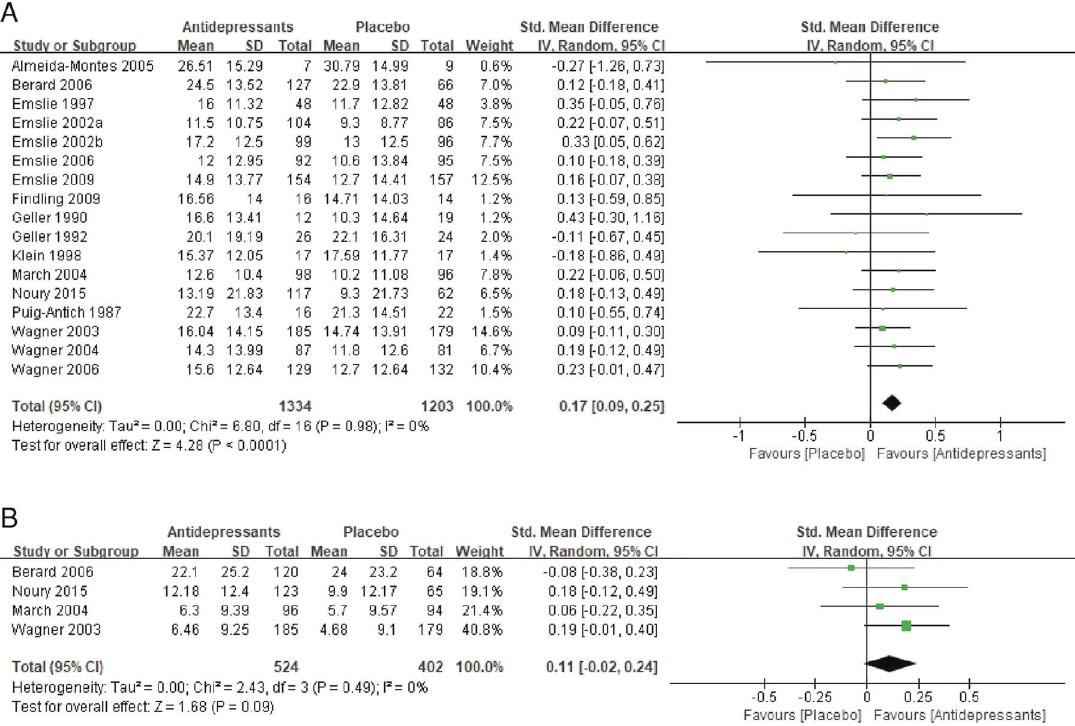
Fig. 2 Meta-analysis of the primary functioning and QOL outcomes. A Forest plot of the standardized mean difference (SMD) of the change in functioning scale scores for the comparison between antidepressants and placebo. B Forest plot of the SMD for the change in quality-of-life scale scores for the comparison between antidepressants and placebo. SD standard deviation, CI con fi dence Supplementary Fig. S1 shows the detailed assessment of risk of bias. We used a funnel plot (Supplementary Fig. S2) and Egger ’ s tests to detect publication bias ( p = 0.530), which indicated that studies.